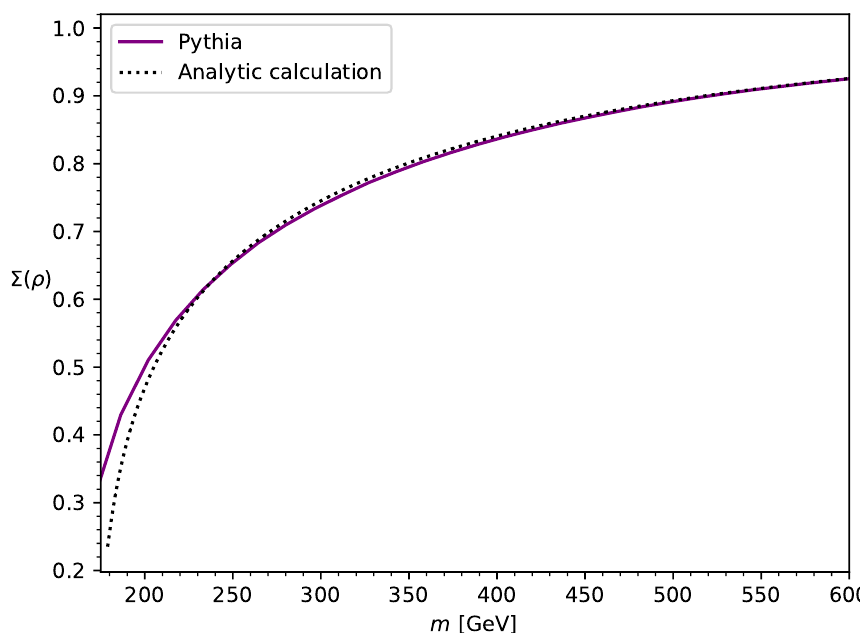
Figure 5. A comparison between our analytical calculation of the cumulative jet mass distribution Σ( ρ ) for top quark initiated jets with ρ = m 2 /R 2 p 2 derived from Pythia